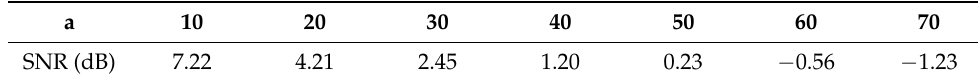
Figure 9. Simulation classification accuracy of the original digit on noisy test sets with non-differential and differential mode: the amplitude of slowly varying noise ( a ) b = 0, ( b ) b = 10, ( c ) b = 20, and ( d ) b = 30. Table 1. DC component, a , and corresponding